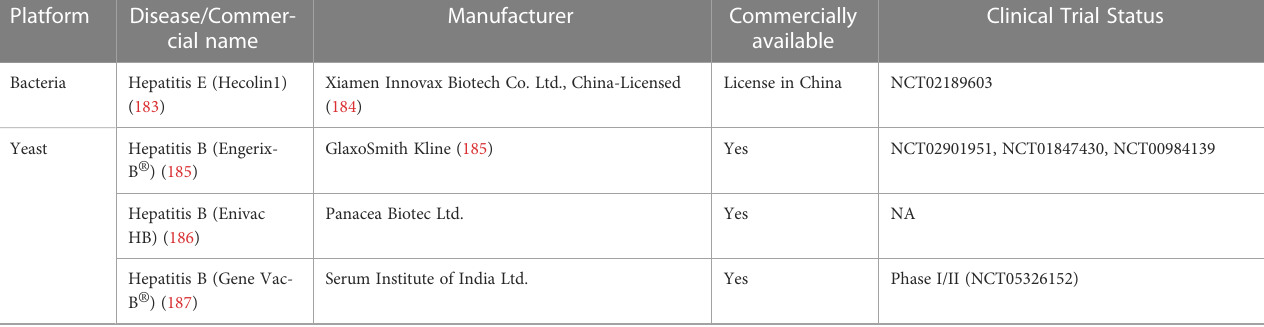
TABLE 6 Licensed VLP based vaccines.